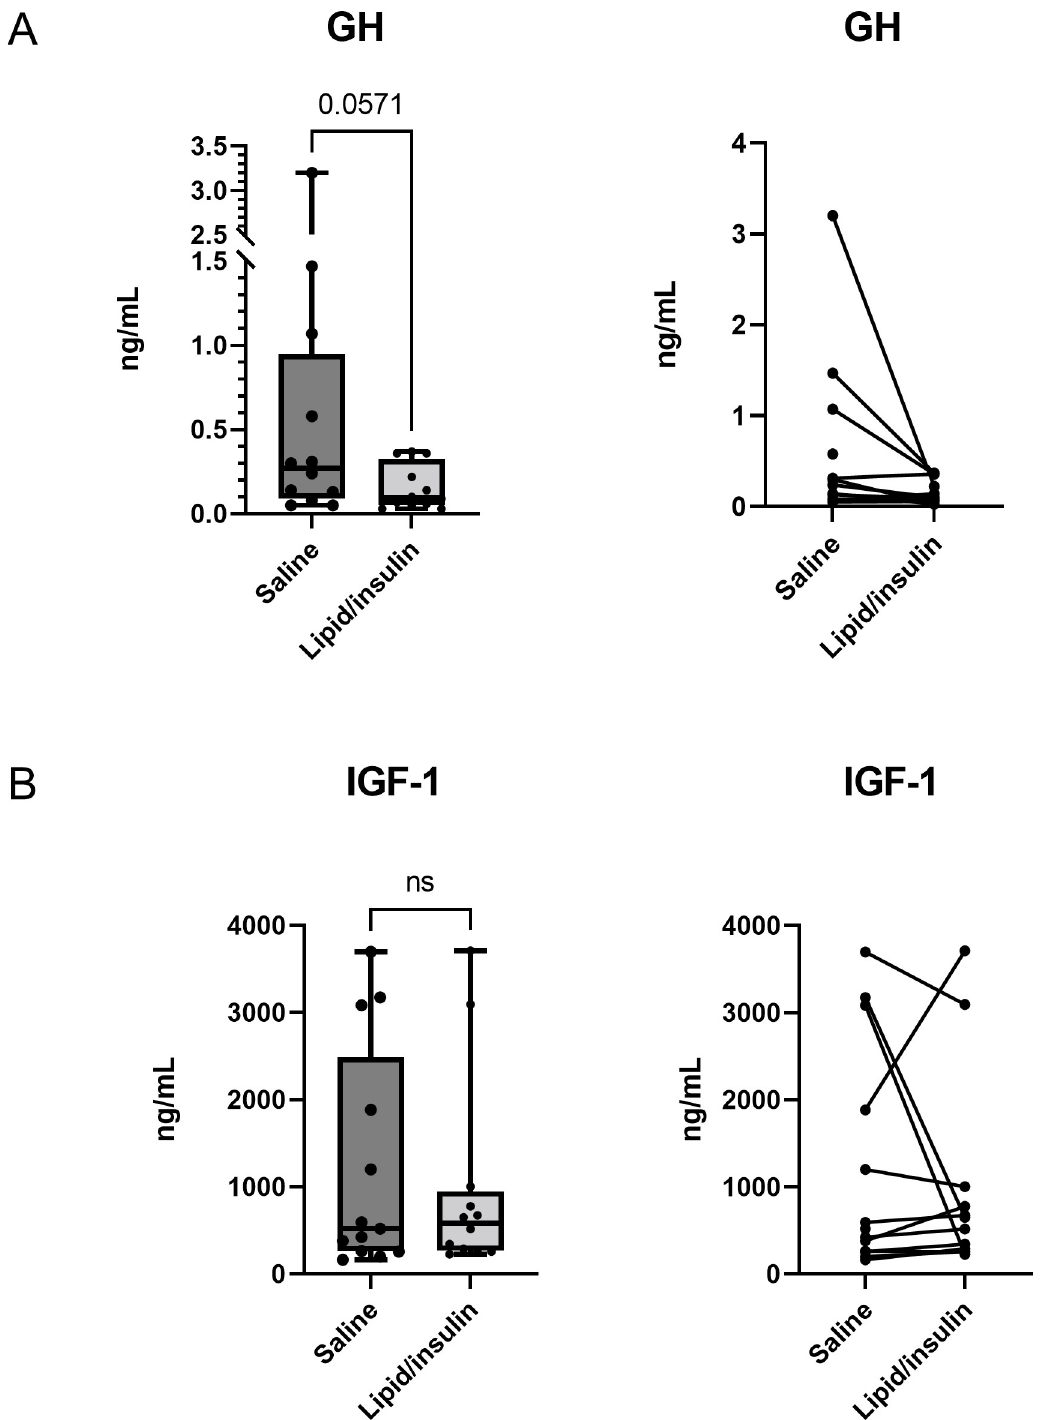
Fig 6. Effect of lipid/insulin infusion on GH and IGF-1. Pooled steady state levels of (A) serum GH and (B) serum IGF-1 were measured as described in methods; boxes encompass 25 th -75 th percentiles, whiskers are maximum and minimum values, and bar indicates median. Spaghetti plots indicate paired data points for each participant for the saline and lipid/insulin infusions. (n = 12).